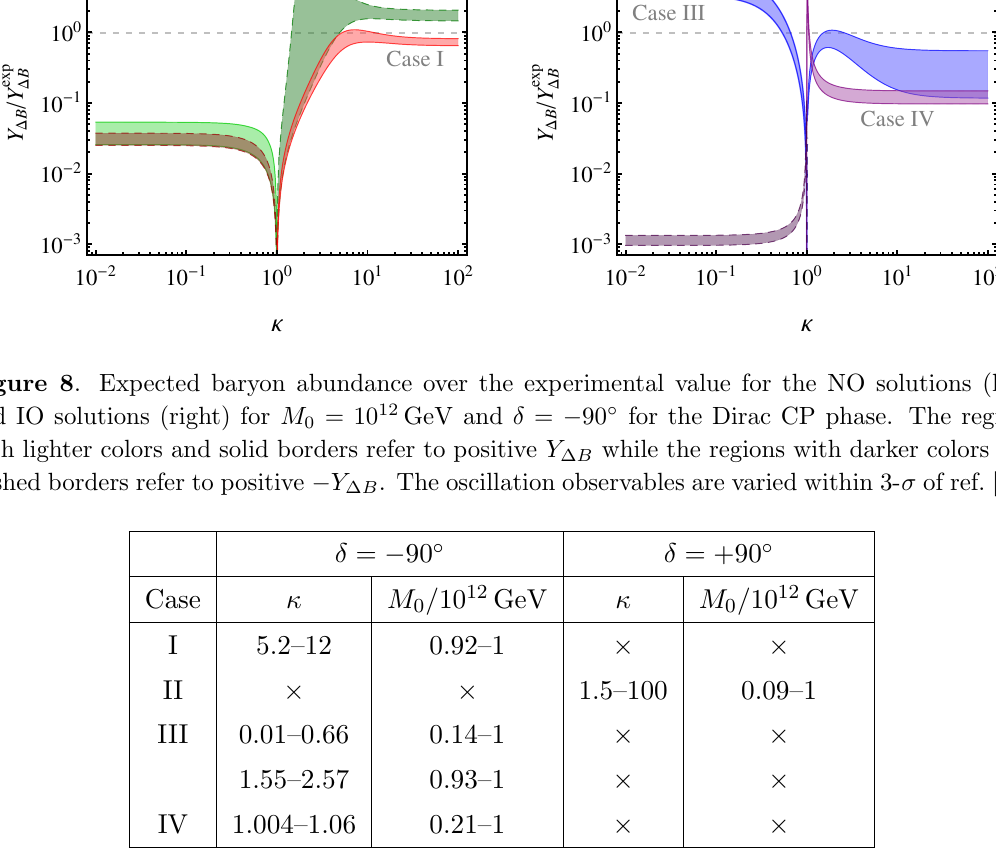
Table 2 . Necessary parameter range of the model for successful